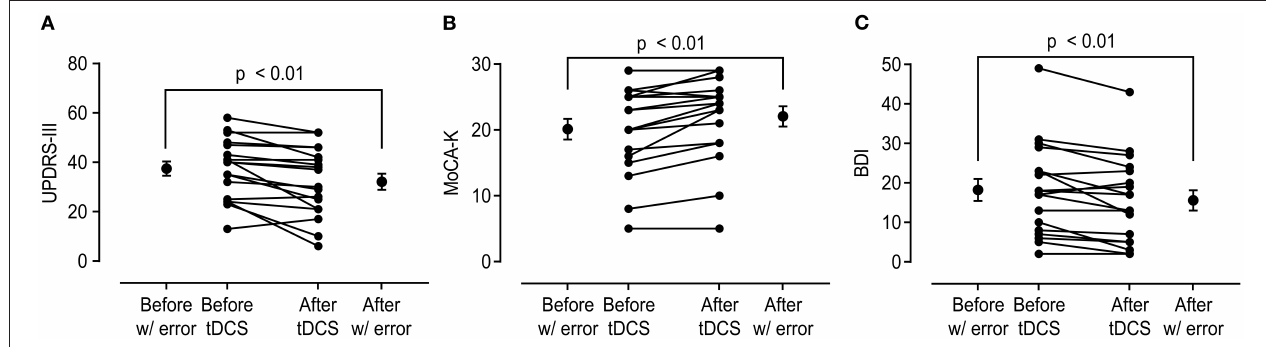
FIGURE 1 | Change in the United Parkinson’s Disease Rating Scale Part 3 (UPDRS-III), Korean version of Montreal Cognitive Assessment (MoCA-K), and Beck Depression Inventory (BDI) scores before and after anodal transcranial direct current stimulation (tDCS) application. (A) Total UPDRS-III score showed significant improvement after anodal tDCS (37.44 ± 12.12 vs. 32.11 ± 13.74, p < 0.01). (B,C) MoCA-K and BDI scores also showed significant changes in comparison between before and after tDCS (MoCA-K: 20.11 ± 6.64 vs. 22.06 ± 6.53, p < 0.01; BDI: 18.22 ± 11.74 vs. 15.56 ± 10.98, p < 0.01).